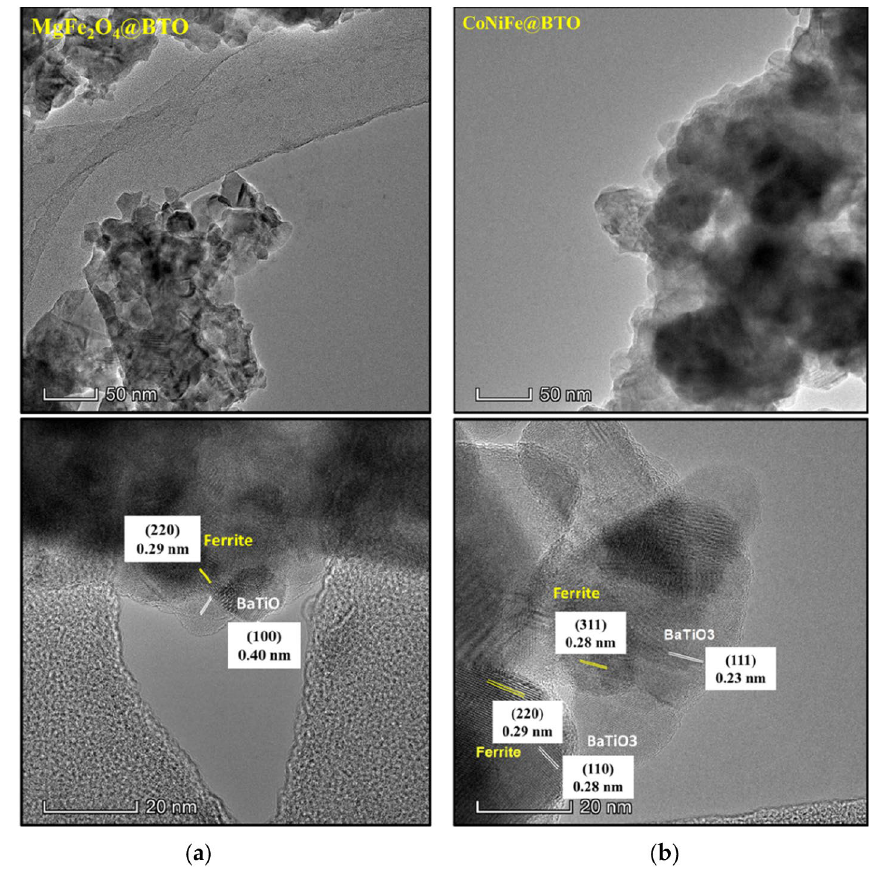
Figure 3. TEM and HR-TEM images of core–shell of ( a ) MgFe 2 O 4 @BTO, ( b ) CoNiFe@BTO MENCs.